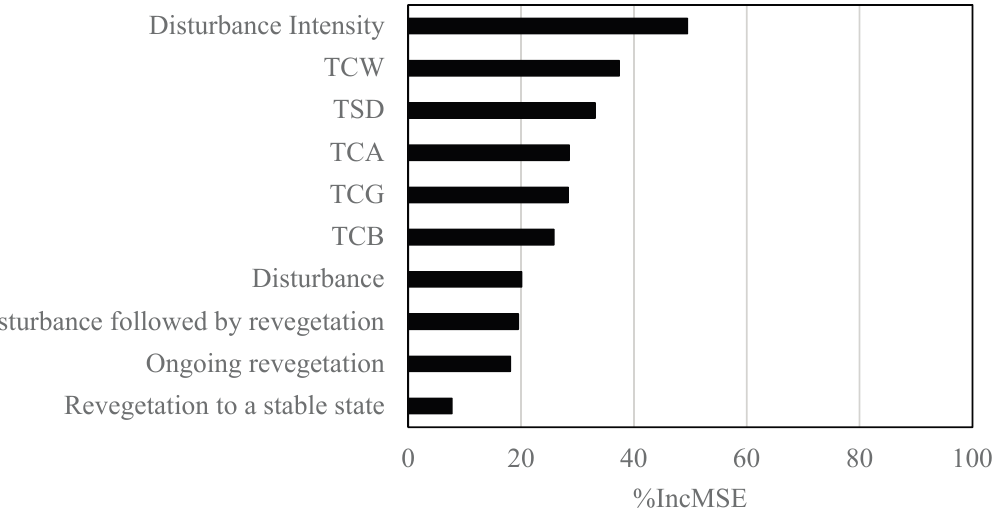
Figure 5. Variable importance of random